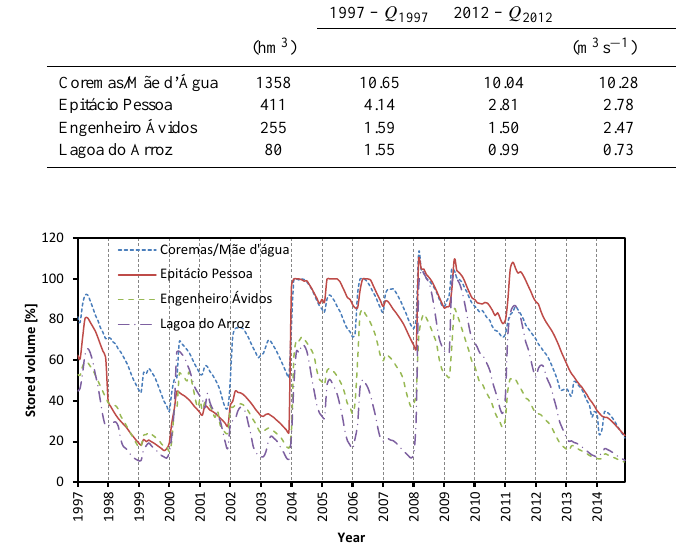
Figure 3. Stored water volume in percentage of full capacity, for the period 1997–2015, of the reservoirs Coremas/Mãe d’água, En- genheiro Ávidos, Lagoa de Arroz and Epitácio Pessoa (data source: AESA, 2015).